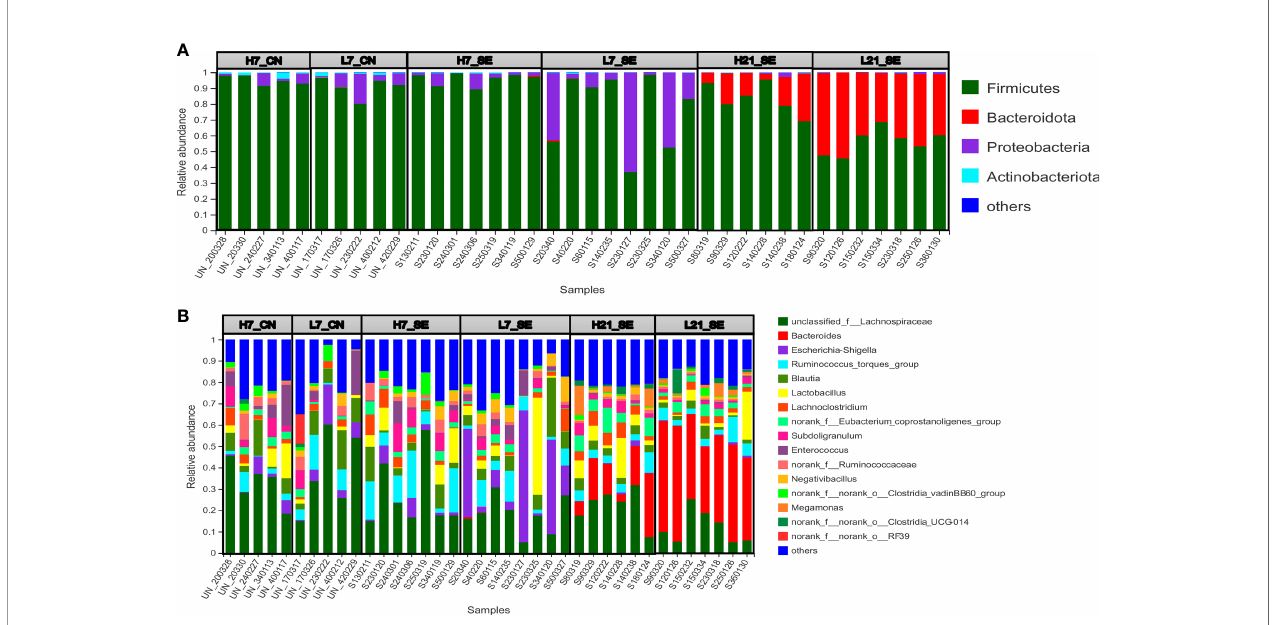
FIGURE 5 | Relative abundance of cecal microbiota phyla and genera of high and low H/L ratio SE-infected chickens at 7 and 21 dpi, by 16s pro fi ling. (A) Relative abundance at phylum level. (B) Relative abundance at genus levels. H7_CN: high H/L non-infected 7 dpi (n = 5); L7_CN: low H/L non-infected 7 dpi (n = 5); H7_SE: High H/L SE-infected 7 dpi (n = 8); L7_SE: Low H/L SE-infected 7 dpi (n = 7); H21_SE: high H/L SE-infected 21 dpi (n = 6); L21_SE: Low H/L SE-infected 21 dpi (n =